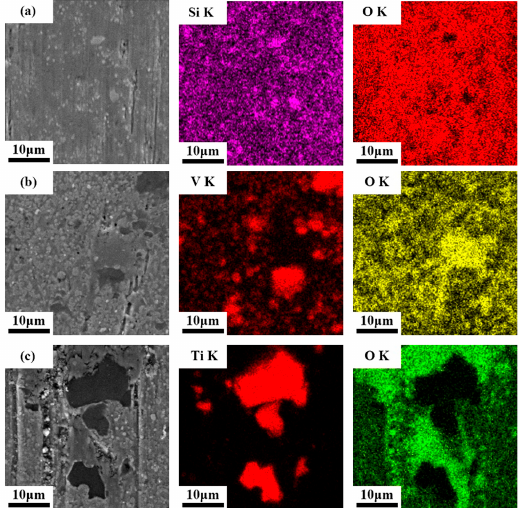
Figure 12. The SEM-SE micrographs of the worn MMCs pin surface and corresponding EDS mapping results. ( a ) MS-3, ( b ) MV-3, and ( c )